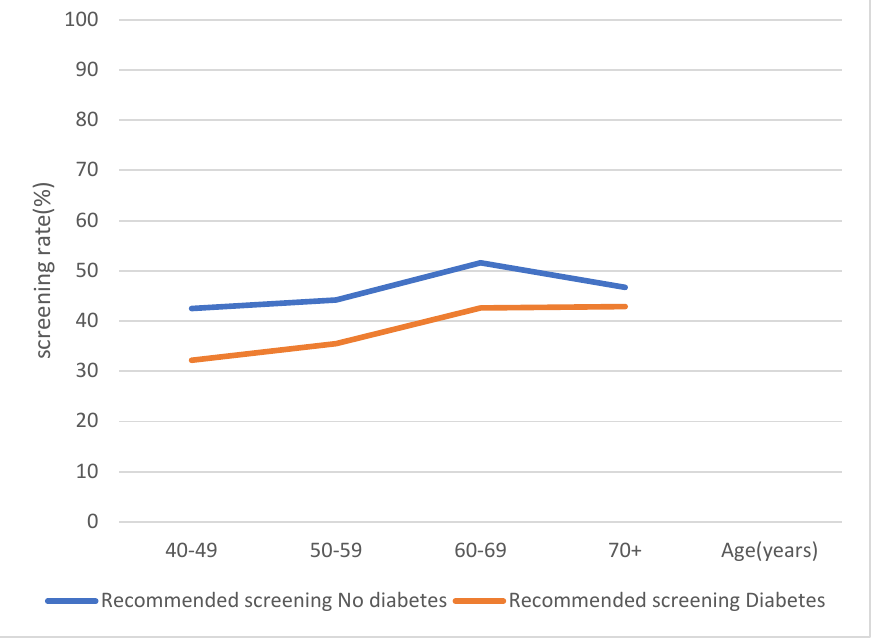
Figure 2. Recommended gastric cancer screening according to diabetes status and age.